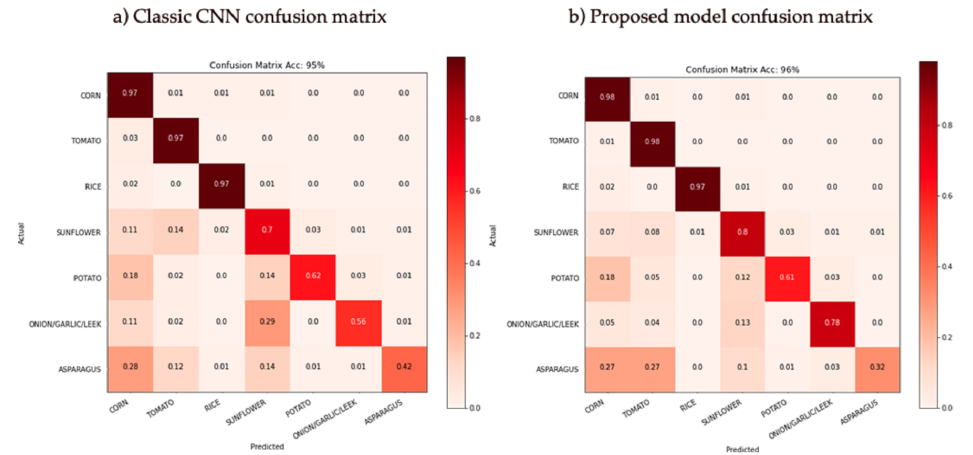
Figure 10. Comparative confusion matrix of the two model architectures. ( a ) Classic convolutional neural network (CNN) confusion matrix; ( b ) Proposed model confusion